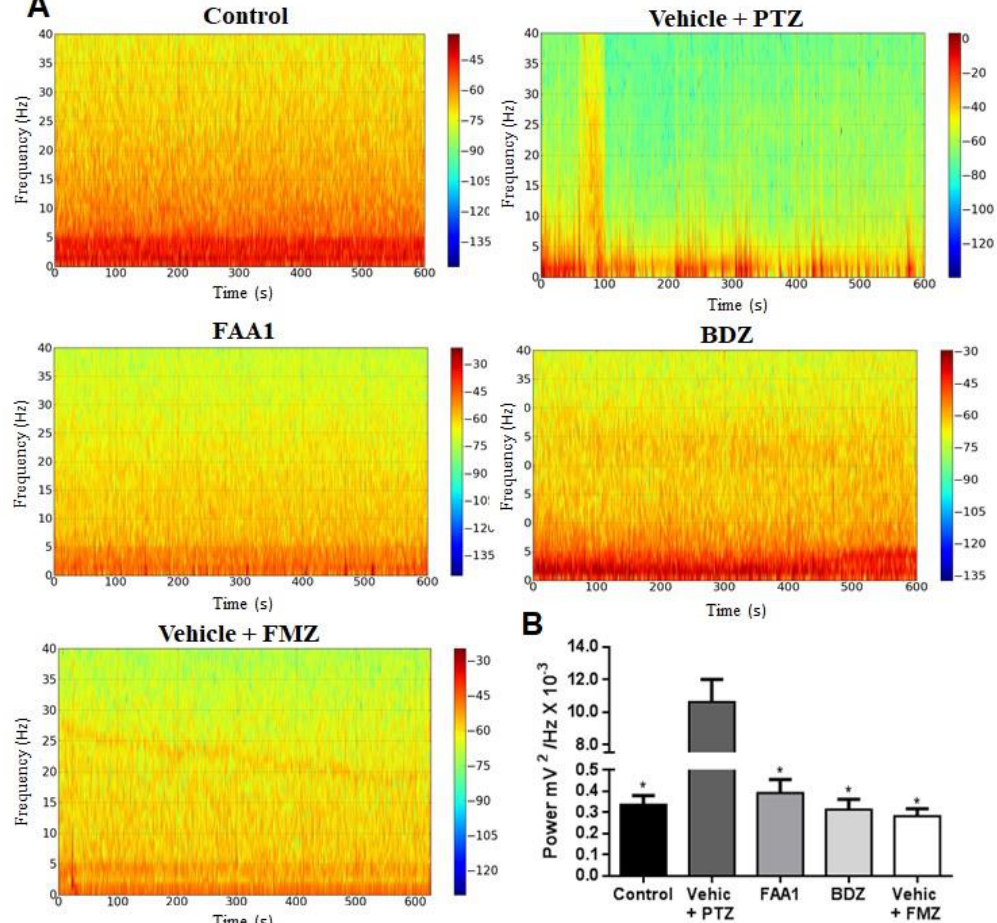
Figure 4. ( A ) Spectrogram of frequency distribution of control and treated groups with BDZ (5 mg/kg) FAA1 (300 mg/kg), FMZ (0.1 mg/kg) and Vehicle + PTZ (60 mg/kg) for 600 s. ( B ) Mean total power distribution. (*) Statistical difference with Vehicle + PTZ group ( p < 0.0001, n = 9), using one-way ANOVA, followed by a Tukey test.